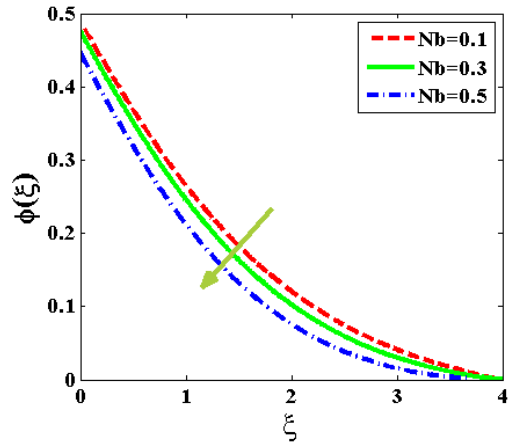
Figure 21. Outlines of 𝜙 at diverse quantities of 𝑁𝑏 .